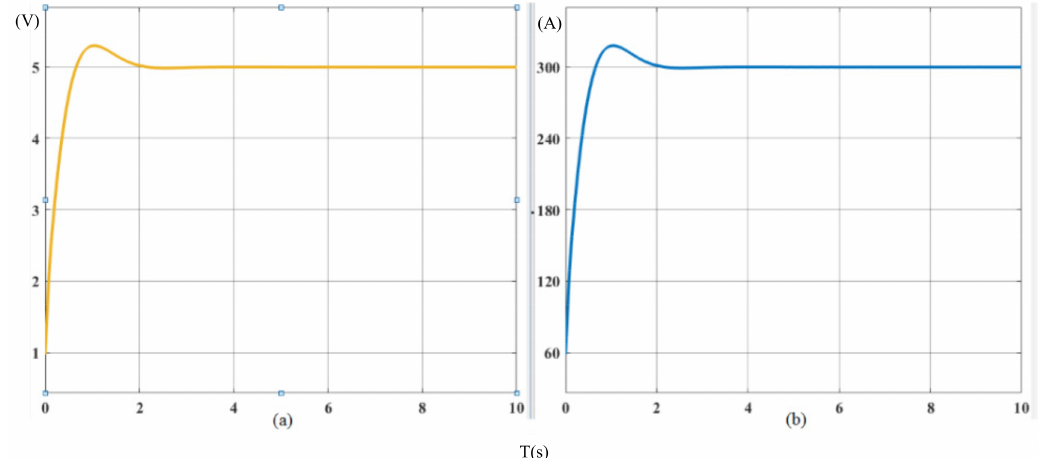
Figure 11. DC output waveforms controlled by the direct power control method: ( a ) voltage waveform; ( b ) current waveform.